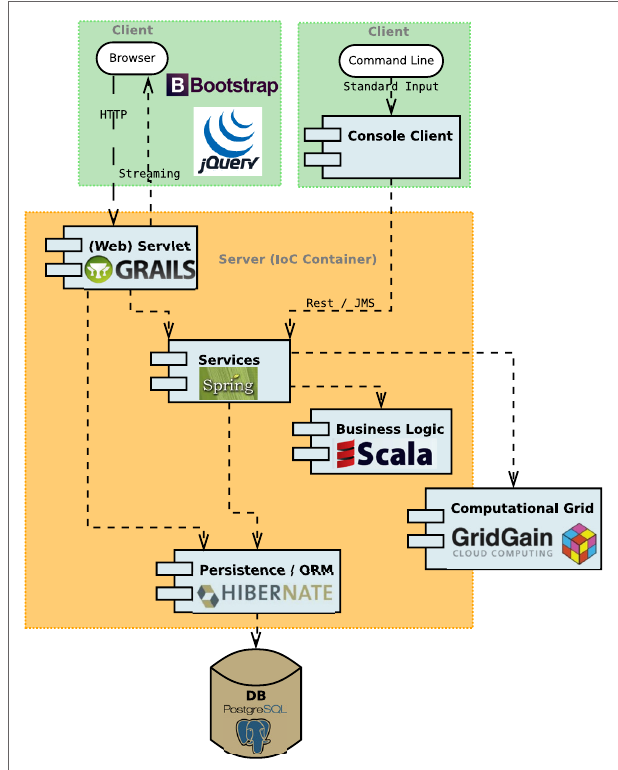
FIGURe 2 | A high-level overview of CoeL’s architecture . It consists of web and console clients, web servlet, services, business logic, persistence layer, and computational grid. The application (IoC) container holding the server side of the application is implemented in the Spring